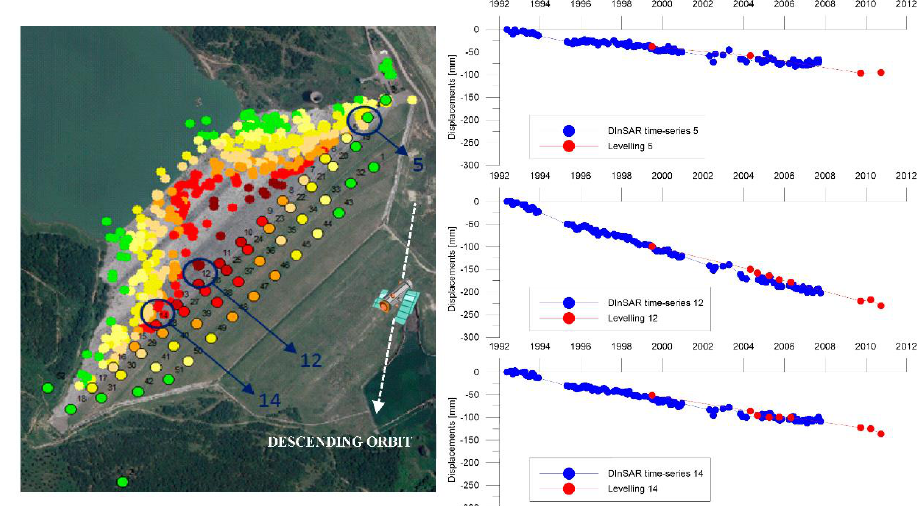
Figure 16. Comparison between the time-series obtained by: DInSAR (blue line) and levelling measurements (dashed red line) on the crest of the dam, the white dashed line indicates the satellite descending orbit (Nord–South).